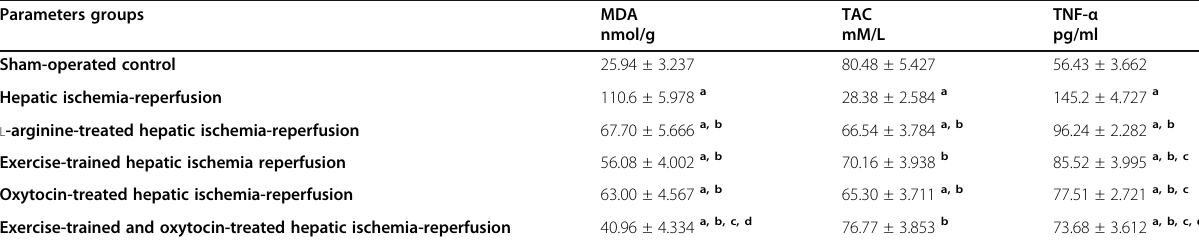
Table 2 Changes in the plasma levels of malondialdehyde (MDA), total antioxidant capacity (TAC), and tumor necrosis factor-alpha (TNF- α ) in the different studied